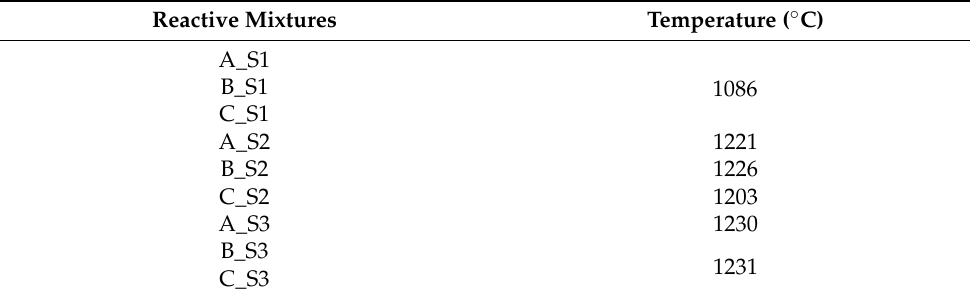
Figure 7. Schematic diagram presenting eutectic temperatures between binary and ternary com- pounds prepared based on Refs. [37,38,40,44 – 47].